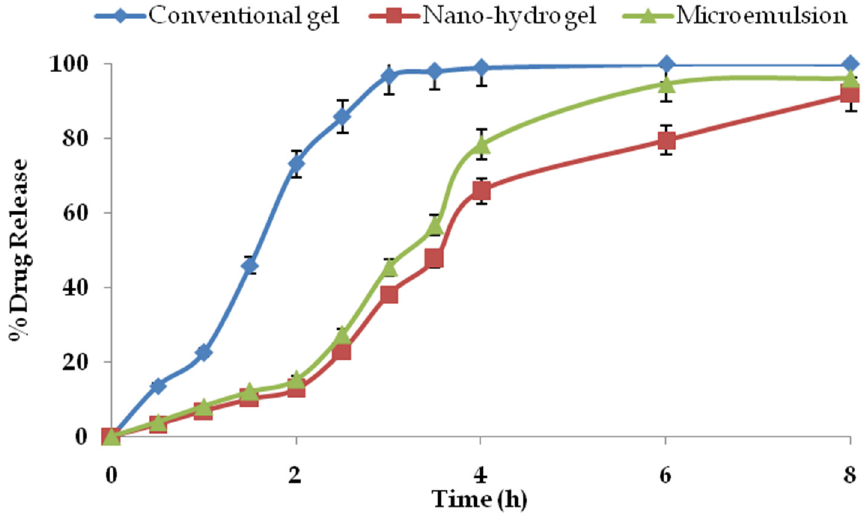
Figure 8. Cumulative drug permeation profiles of mangiferin from the studied systems (n = 3) .